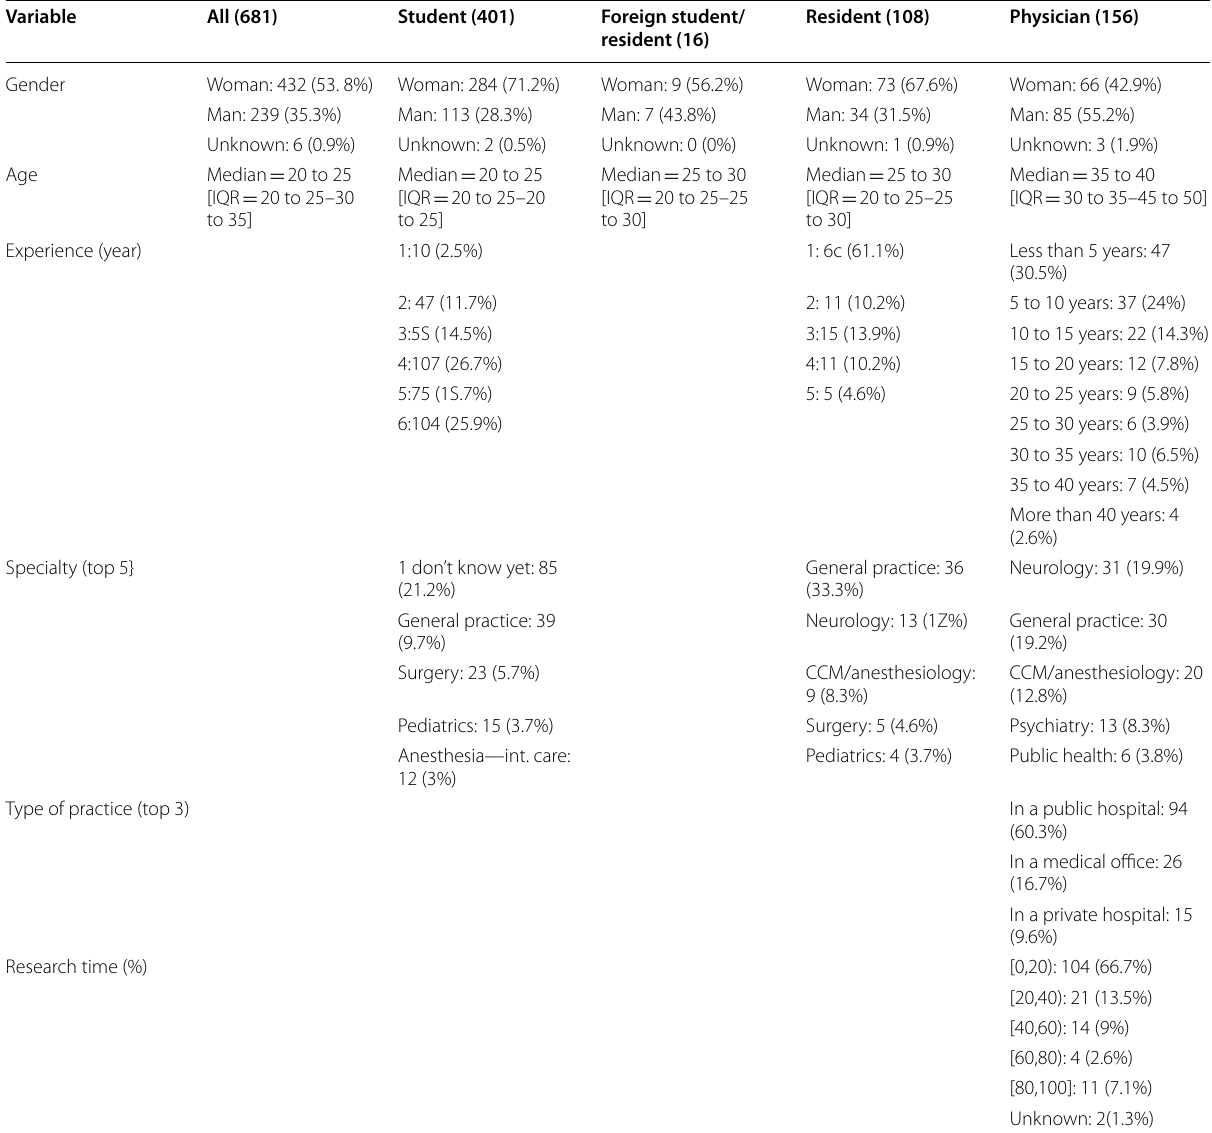
Table 2 Demographics from participants of the “test results interpretation” exercise (N